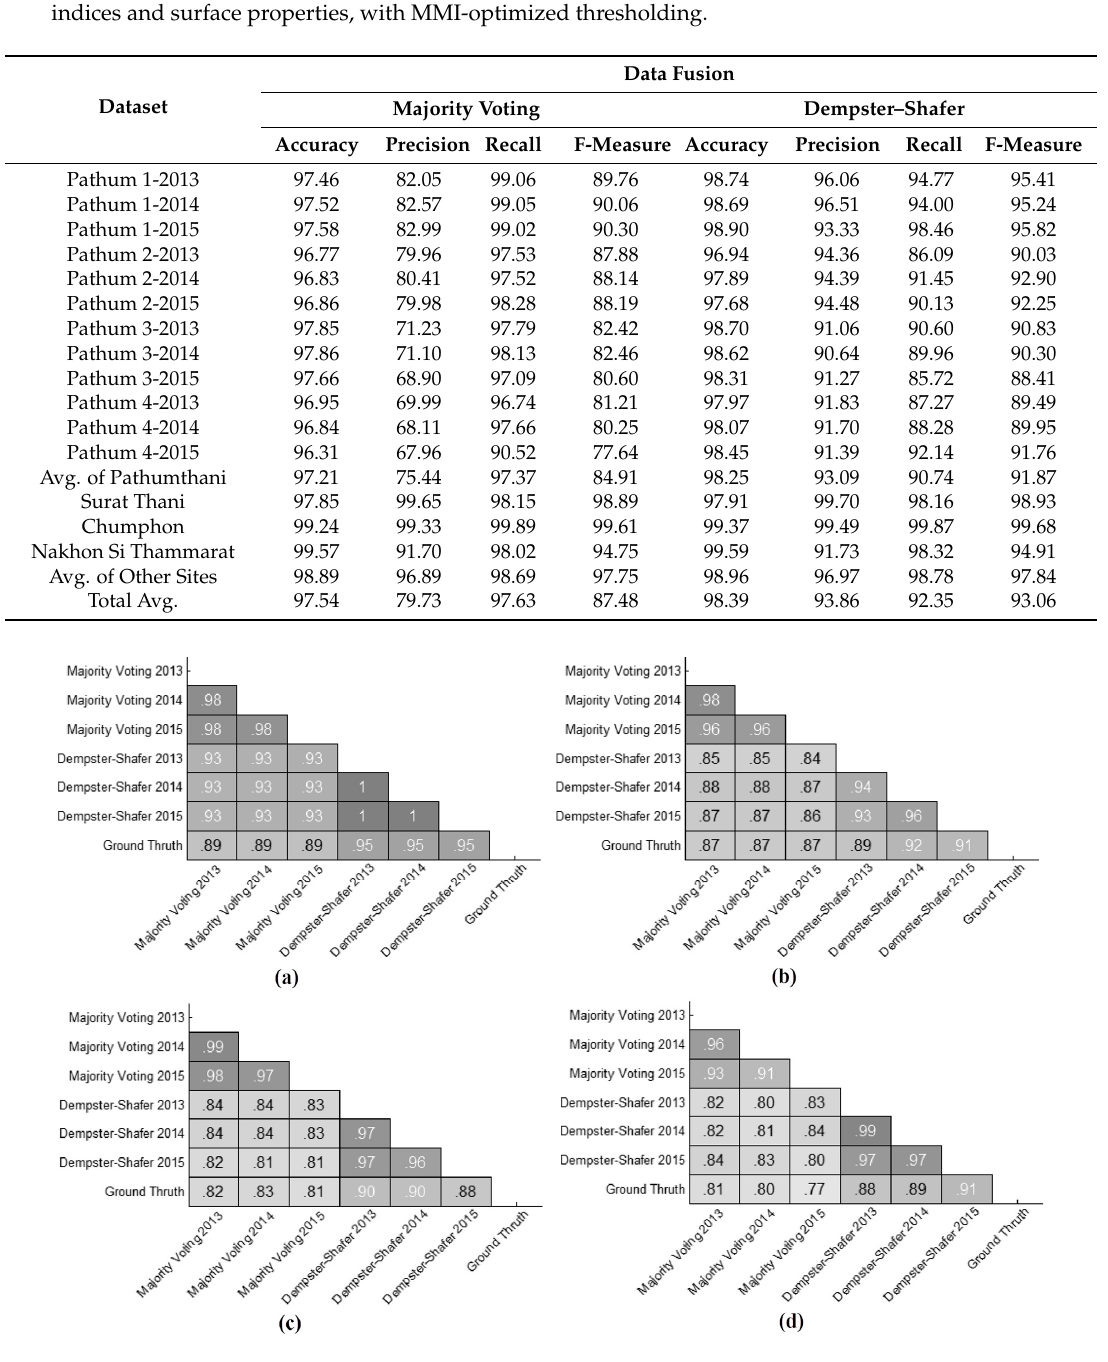
Figure 6. Correlation results of Pathumthani for image one ( a ), two ( b ), three ( c ), and four ( d ). If DSM was just used for fusion but not incorporated during MMI optimization, only the MNDWI and NDWI2 indices would be mutually assessed for thresholding. The results of fused water extraction in Pathumtani during 2013, by using Equation (10) are given in Table 4. Disregarding surface attributes, the optimal threshold of these indices changed from NDWI2 > 0.016 and MNDWI > 0.032 to NDWI2 > 0.045 and MNDWI > 0.09. However, DSM, whose topographic thresholds were set to zero, was still used during the fusion. Accordingly, the averaged extraction accuracies for the respective samples were slightly improved, compared to those in Table 3 when Dempster–Shafer fusion was used. Specifically, the averaged accuracy, precision, recall, and F-measure increased from 98.09%, 93.33%, 89.68%, and 91.44% to 98.63%, 92.26%, 94.85%, and 93.51%, respectively. If the Majority Voting scheme was used instead, then the results deteriorated. Notably, the Dempster–Shafer fusion of the indices and DSM was generally accurate and independent of mutual threshold settings. Both two- and four-variable MMI provided similar results and the four-variable MMI performed equally well by using either of the fusions. Dempster– Shafer fusion with four-variable MMI optimization was therefore preferred. To ensure its generalization ability, the MMI-based thresholding and thematic layer fusion were applied in the other cities that had different climates, and resident and geographical characteristics, namely Chumphon, Surat Thani, and Nakhon Si Thammarat. The resultant extractions are illustrated in Figure 7 and their respective numerical assessments are listed in Table 3. These results are consistent with those of Pathumthani; Dempster–Shafer yielded more accurate extractions than its peer, with mean accuracy, precision, recall, and F-measure of 98.96%, 96.97%, 98.78%, and 97.84%, respectively.